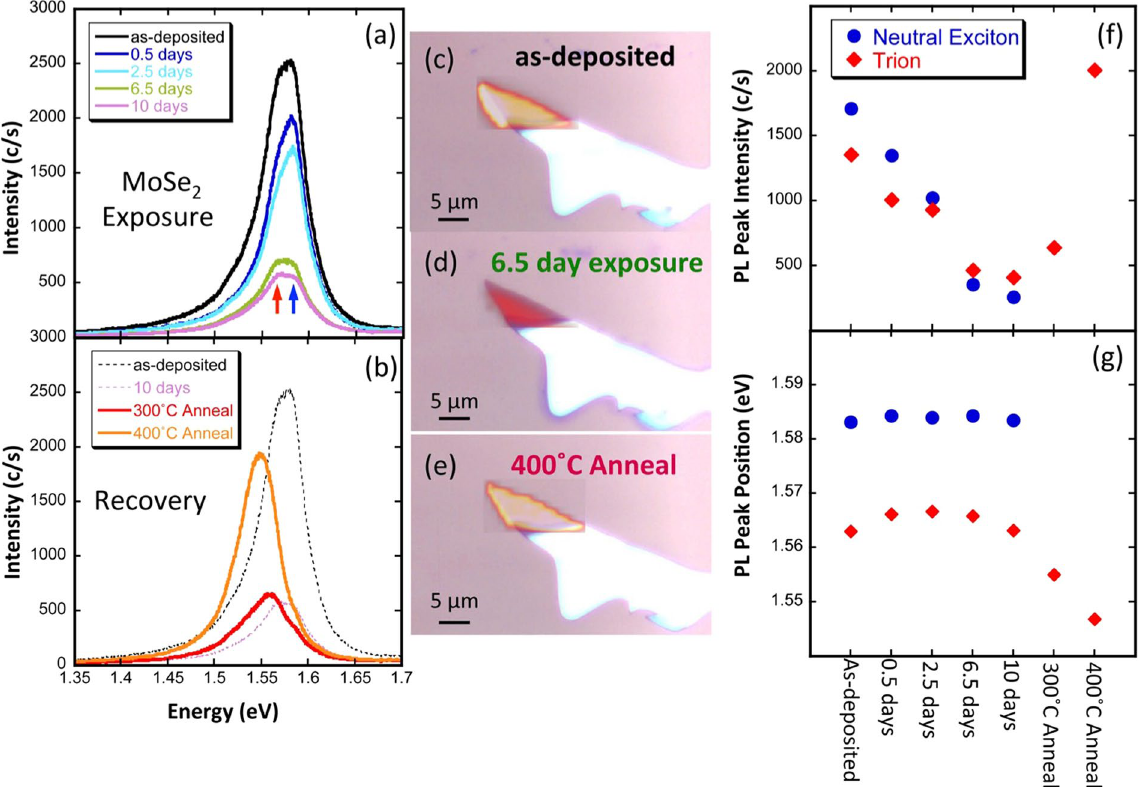
The as-deposited film lost ~80% of its intensity after 10 days of exposure, indicating a partial transition to the 1T phase. ( b ) PL spectra on the same MoSe 2 film after a series of annealing steps compared to the as-deposited and partially transitioned film, as indicated. After annealing at 400 °C, the film recovered to within ~80% of the original intensity, indicating a transition back to the 2H phase. ( c – e ) PL peak intensity maps superimposed onto the optical image of the MoSe 2 film showing both the decrease of intensity/recovering of the film and the uniformity of the emission. ( f ) PL peak intensity as a function of event further elucidating the effect of TPA exposure and annealing. ( g ) PL peak position of the two peaks indicated by the arrows in ( a ) as a function of exposure/annealing event. In ( f ) and ( g ), the blue circles are data for the neutral exciton, the red diamonds are for the trion, and error bars are on order of the symbol